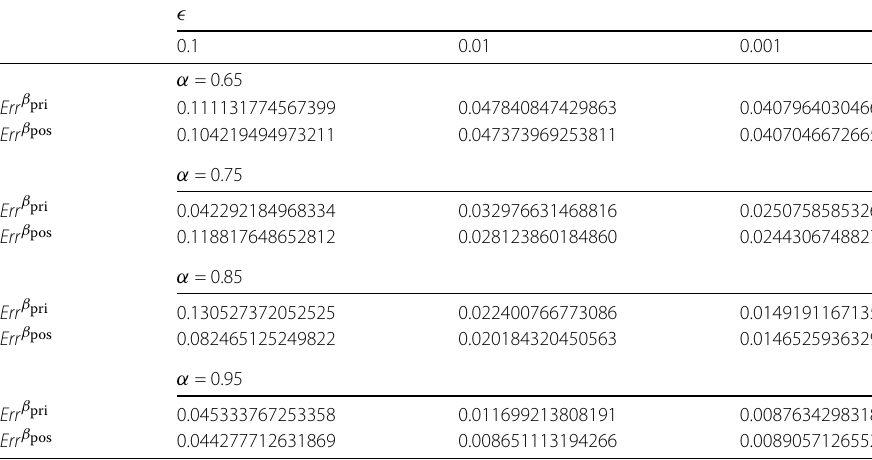
Table 2 Error estimates between the exact and regularized solutions for τ = 1.7, α ∈ { 0.65,0.75,0.85,0.95